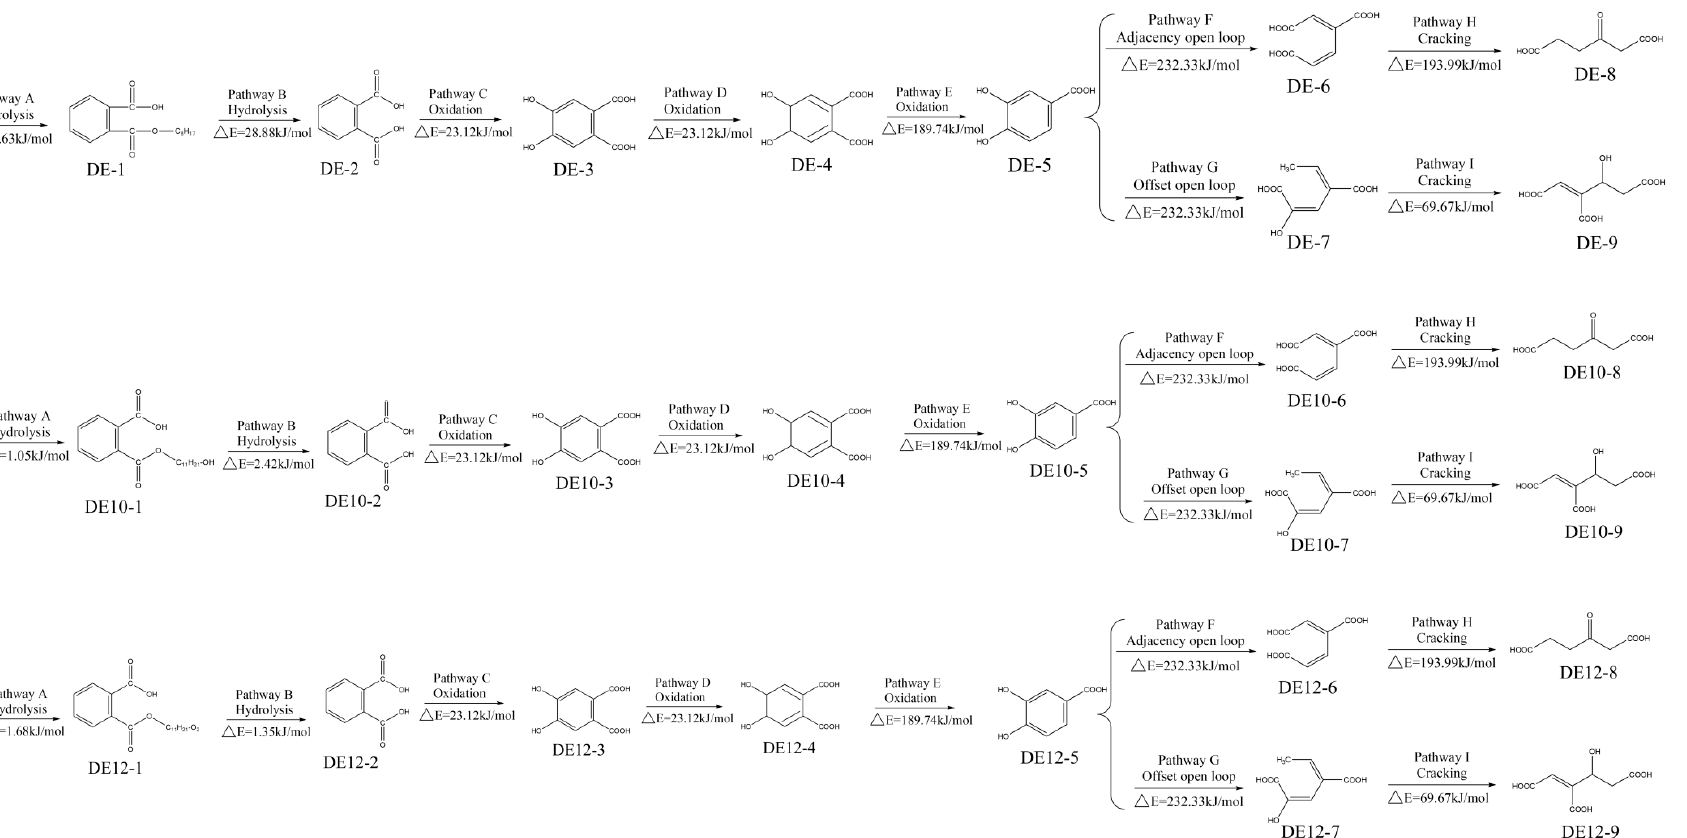
Figure 4. Photodegradation pathway ( A )/Microbial degradation pathway ( B ) associated with DEHP and its substitutes in the soil environment.